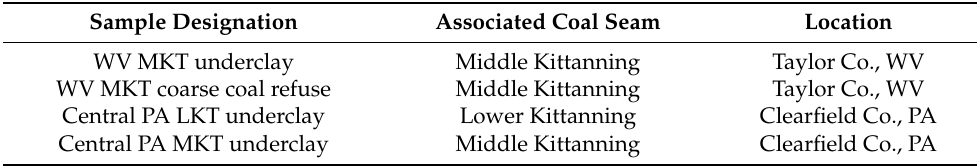
Table 1. Sample designations with general location and associated coal